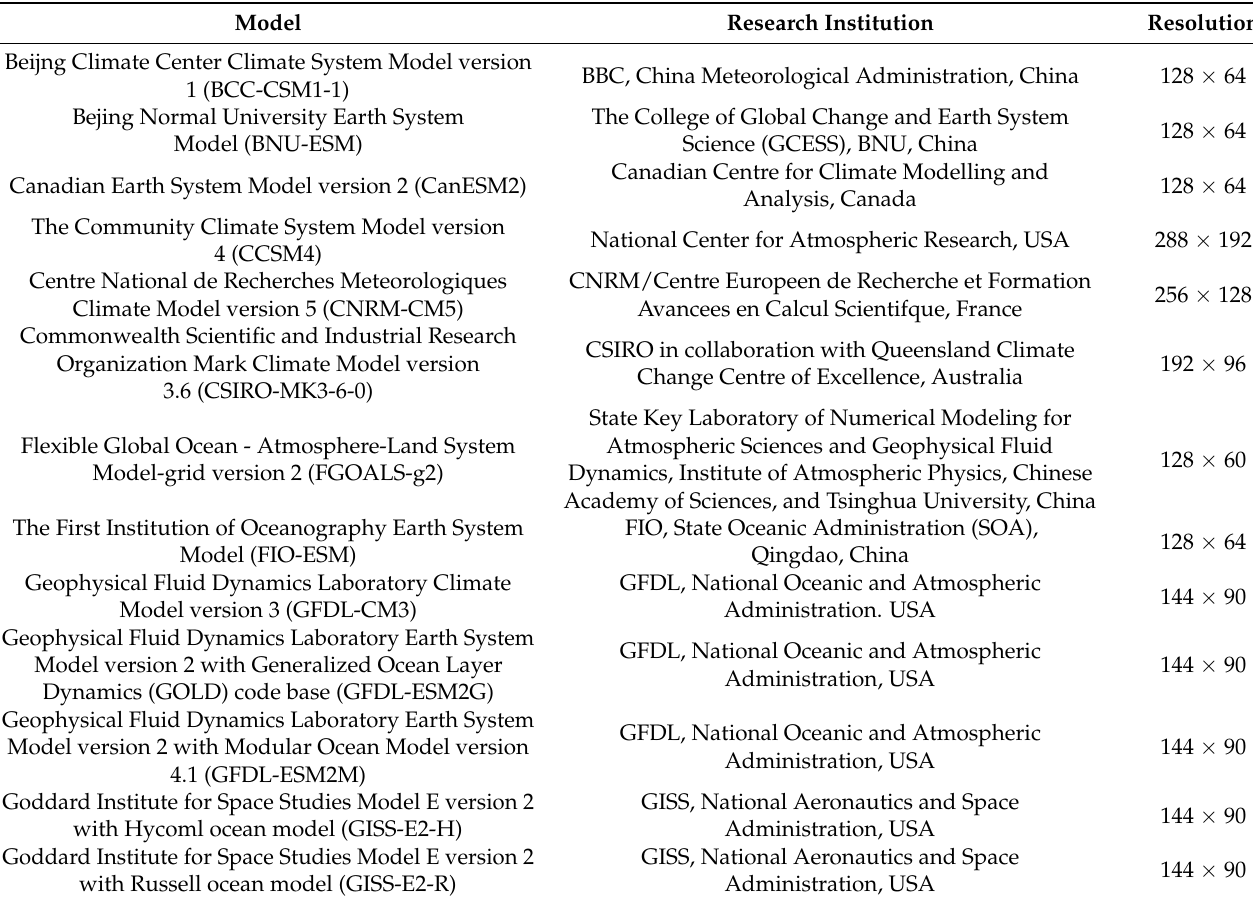
Table 5. The basic information about 21 CMIP5 global climate